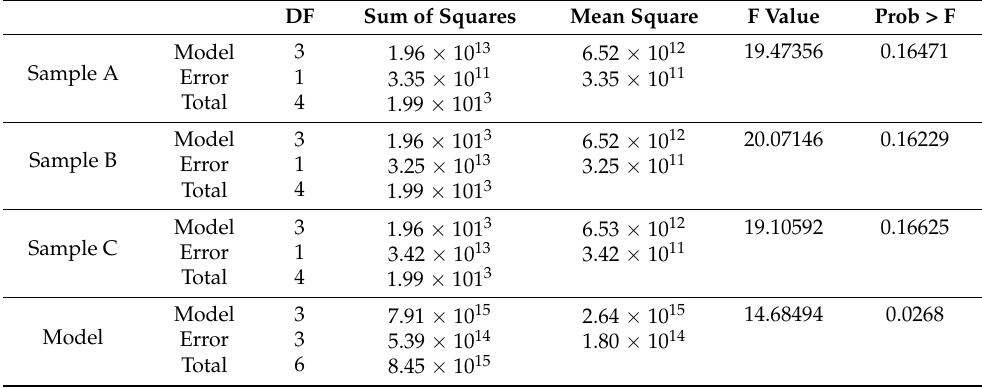
Table 8. ANOVA analysis of tension–tension fatigue